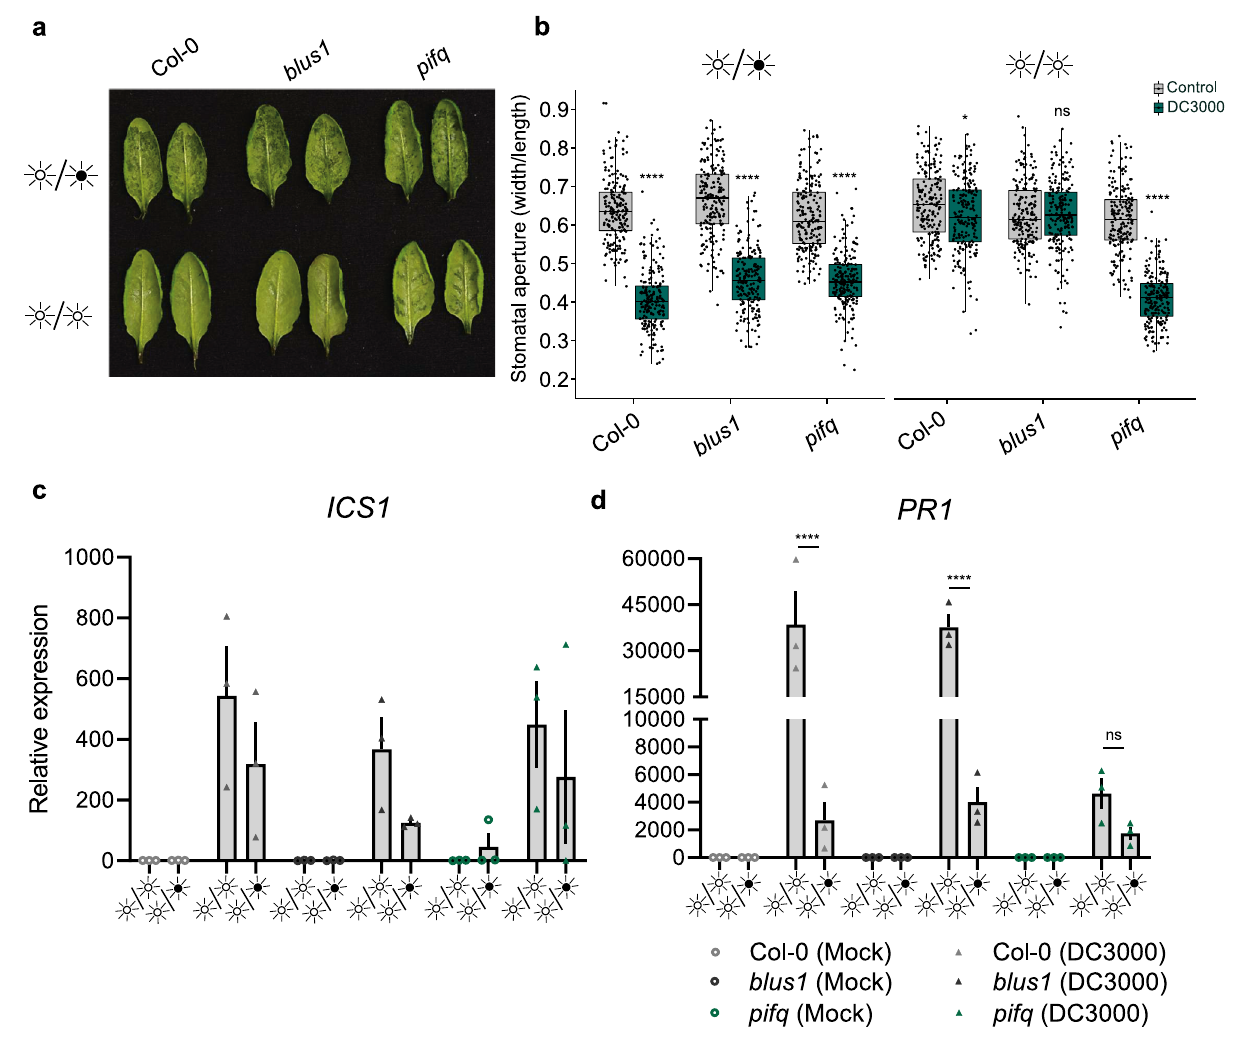
Fig.6|PotentialimplicationofPIFsinpreventingbacterialinductionofwater- soaked lesions under light. a Water-soaking phenotypes of Arabidopsis WT (Col- 0), blus1 and pifq mutant plants syringe-in fi ltrated with Pst 3000 (1×10 8 CFU/ml) under the indicated light settings. Photos were taken at 24h post in fi ltration (hpi). b Stomatal aperture measurements from infected leaves displayed in a ( n =192 stomata for all LD DC3000 data, n =196 stomata for all control data, n =199stomataforallLLDC3000data).Expressionlevels,assessedbyqRT-PCR,of ICS1 ( c ) and PR1 ( d ) marker genes in Arabidopsis WT (Col-0), blus1 and pifq mutant plants infected with Pst DC3000 (1×10 8 CFU/ml) or with control solution (MgCl